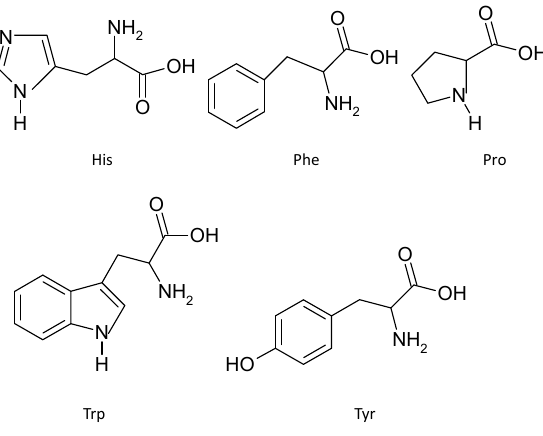
Figure 4. The chemical structures of five antioxidant amino acids with ring.